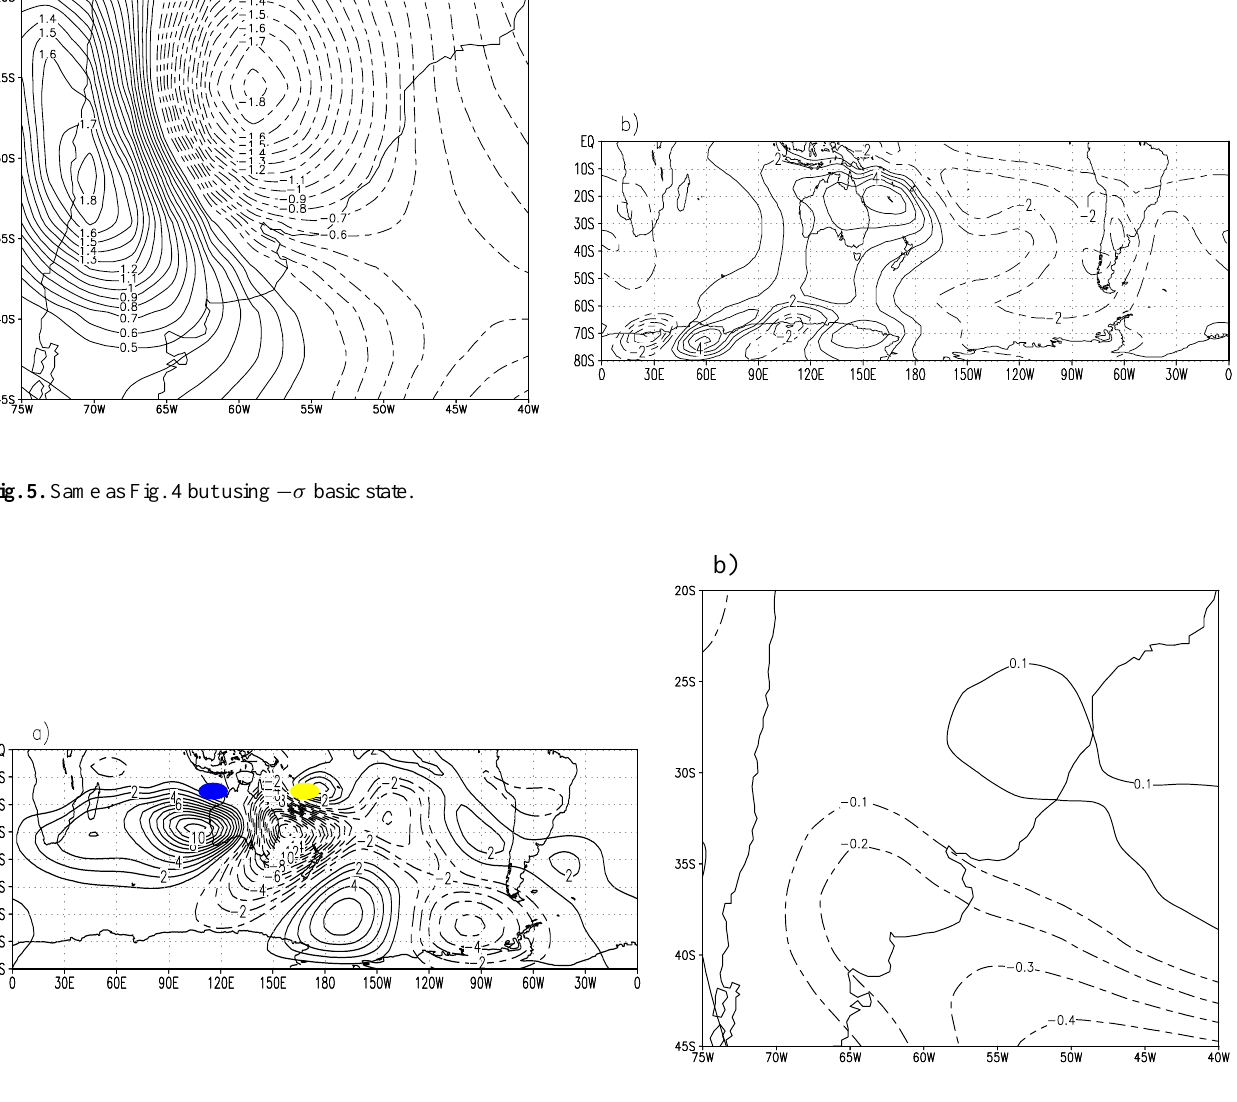
Fig. 6. (a) Stream function anomalies (1 × 10 − 6 m 2 s − 1 ) at 250hPa and (b) surface temperature anomalies ( ◦ C) on day 10 of integration, corresponding to + σ basic state with forcing at 170 ◦ E–15 ◦ S and 120 ◦ E–15 ◦